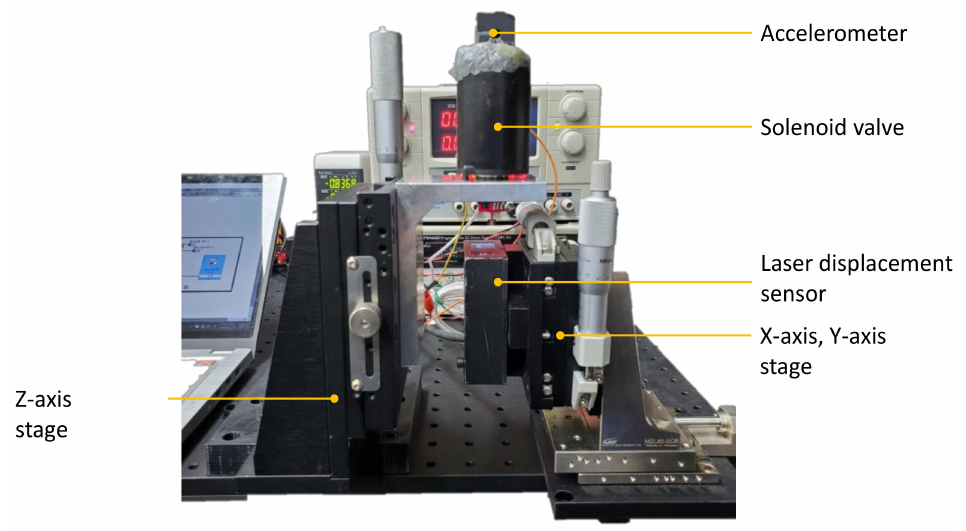
Figure 4. Experimental setup for measuring plunger displacement.